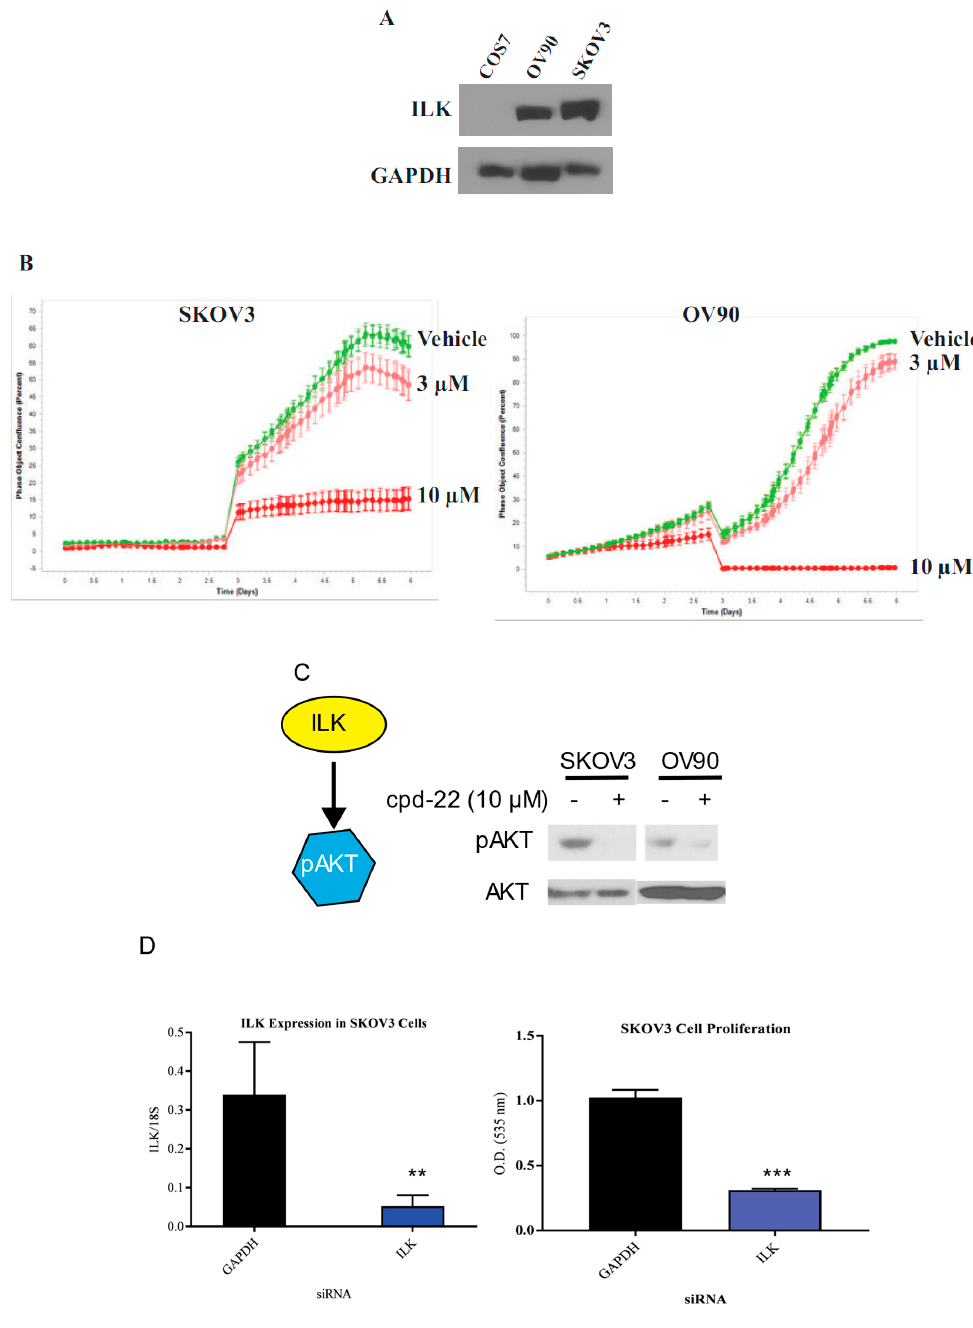
Figure 5. In vitro validation of the ILK pathway. ( A ) Protein expression of ILK-1 in two ovarian cancer cell lines, SKOV3 and OV90 and non-cancerous COS7 cells. Protein was extracted from the cells, fractionated on an SDS-PAGE, and Western blot for ILK-1 and GAPDH was performed. ( B ) INCUCYTE proliferation assay of SKOV3 and OV90 cell lines in the presence of vehicle (DMSO) or 3 or 10 µ M ILK inhibitor compound 22. Images were obtained periodically for the indicated time-points. ( C ) Phosphorylation of AKT was inhibited by ILK-1 inhibitor compound 22. SKOV3 and OV90 cells were treated with compound 22 for 4 h. Cells were harvested, protein extracted, and Western blot with phospho-AKT and total AKT antibodies was performed. ( D ) ILK-1 siRNA inhibits SKOV3 cell proliferation. SKOV3 cells were transfected with ILK-1 or GAPDH siRNA. Six days after transfection (re-transfected after day 3) mRNA expression of ILK-1 and 18S (left) and cell proliferation (right) by sulforhodamine B (SRB) assay were measured ( n = 3). ** p < 0.01; *** p <